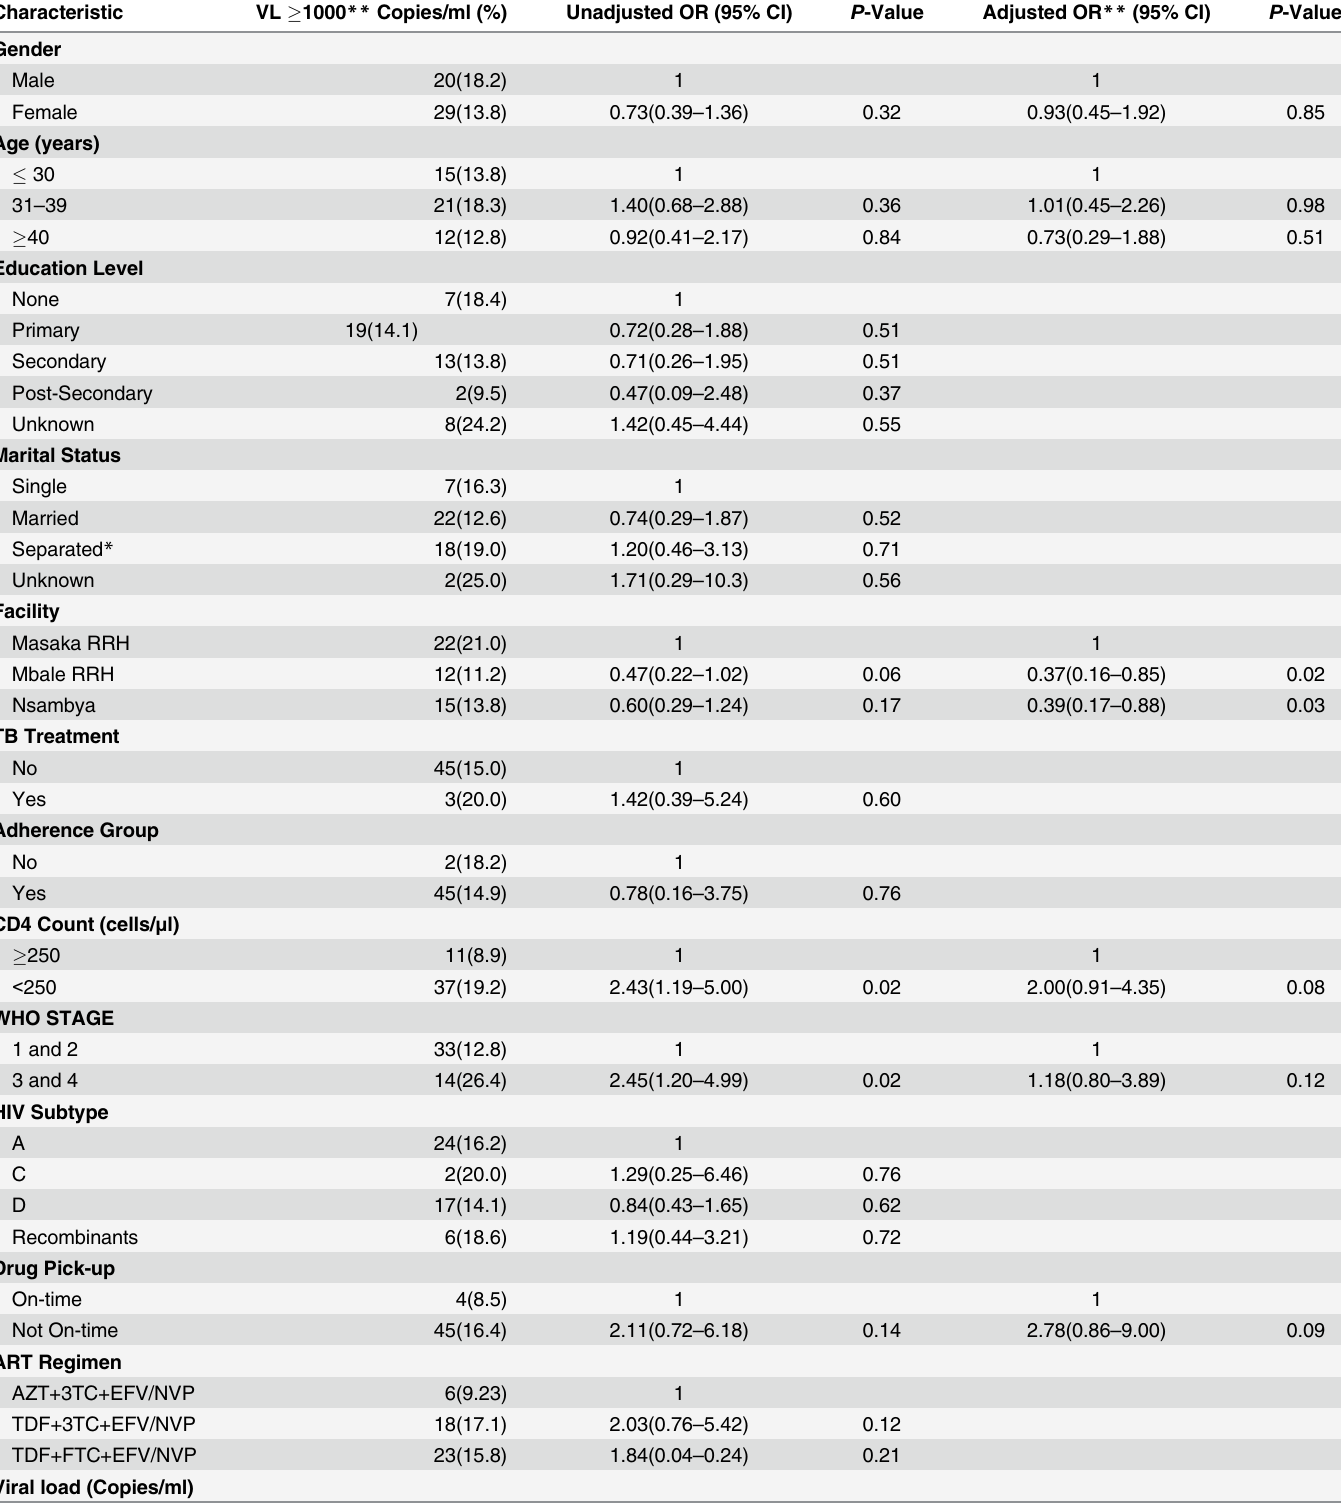
Table 5. Association between baseline patient characteristics and Virological failure at 12 Months after ART Initiation